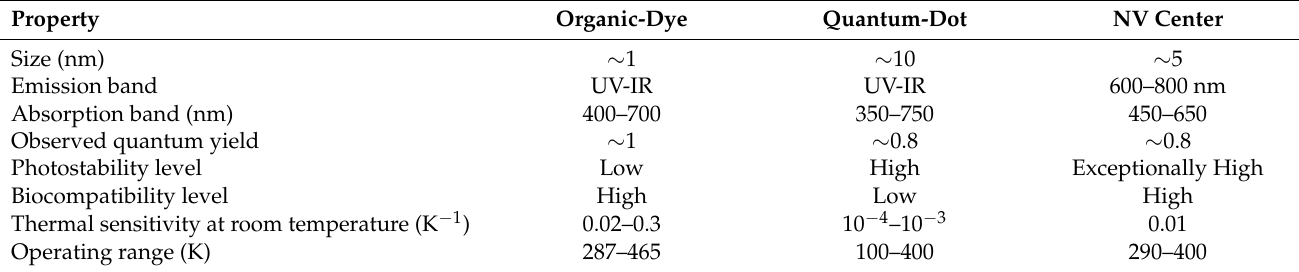
Figure 4. Illustration of the multispectral superresolution microscopy using NV centers. ( a ) FNDs shown as arbitrarily dispersed bright spots. ( b ) Single FND illustrated in large view. ( c ) The ODMR spectra of single FND, as in ( b ), displaying two differently orientated NV centers. ( d ) The reconstructed superresolution image indicating red and blue spots as two different NV centers. Table 2. A comparison between various fluorescent nanosensors